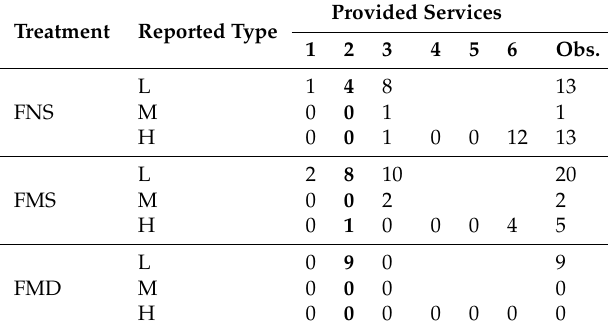
Table A12. Cont . Treatment Reported Type